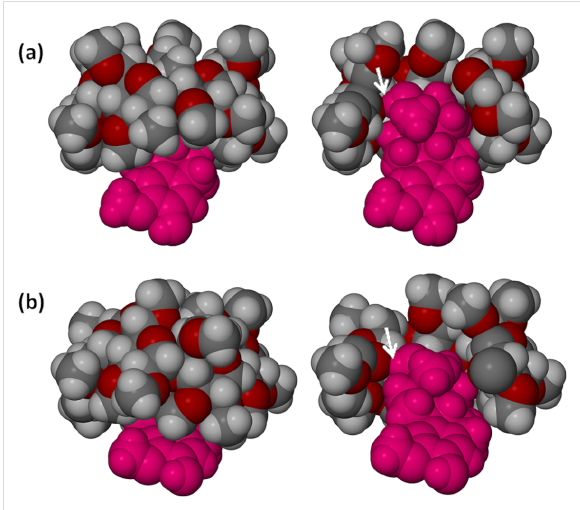
Figure 4: Space-filling images of complex unit A (as representative of units A and B) (a) and complex unit C (b) of TRIMEB·2ME. The images on the left show guest residues (magenta) protruding from the second- ary side of the host molecule while the images on the right are cutaway views highlighting the common (guest)O19–H···O4(host) hydrogen bond, indicated by arrows.